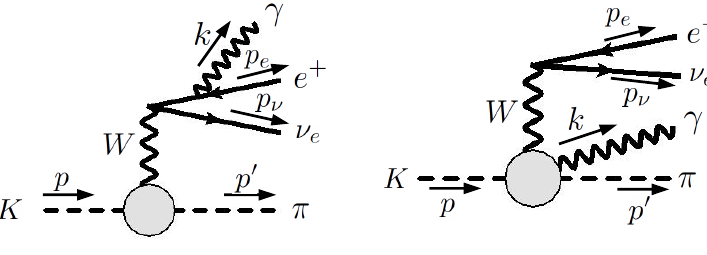
Figure 2 . The real photon emission